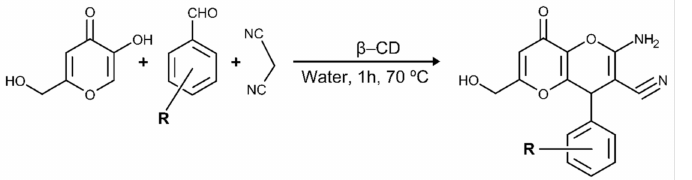
Figure 2. Synthesis of KA derivatives obtained from malononitrile, aldehyde, and KA and catalyzed by β -CD previously reported by Kataev et al. (2016)